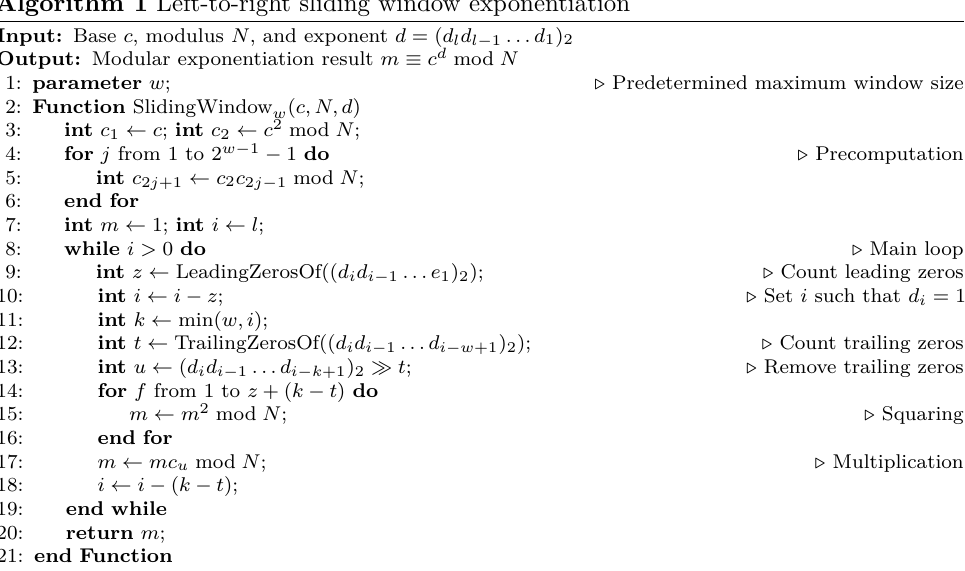
Algorithm 1 Left-to-right sliding window exponentiation